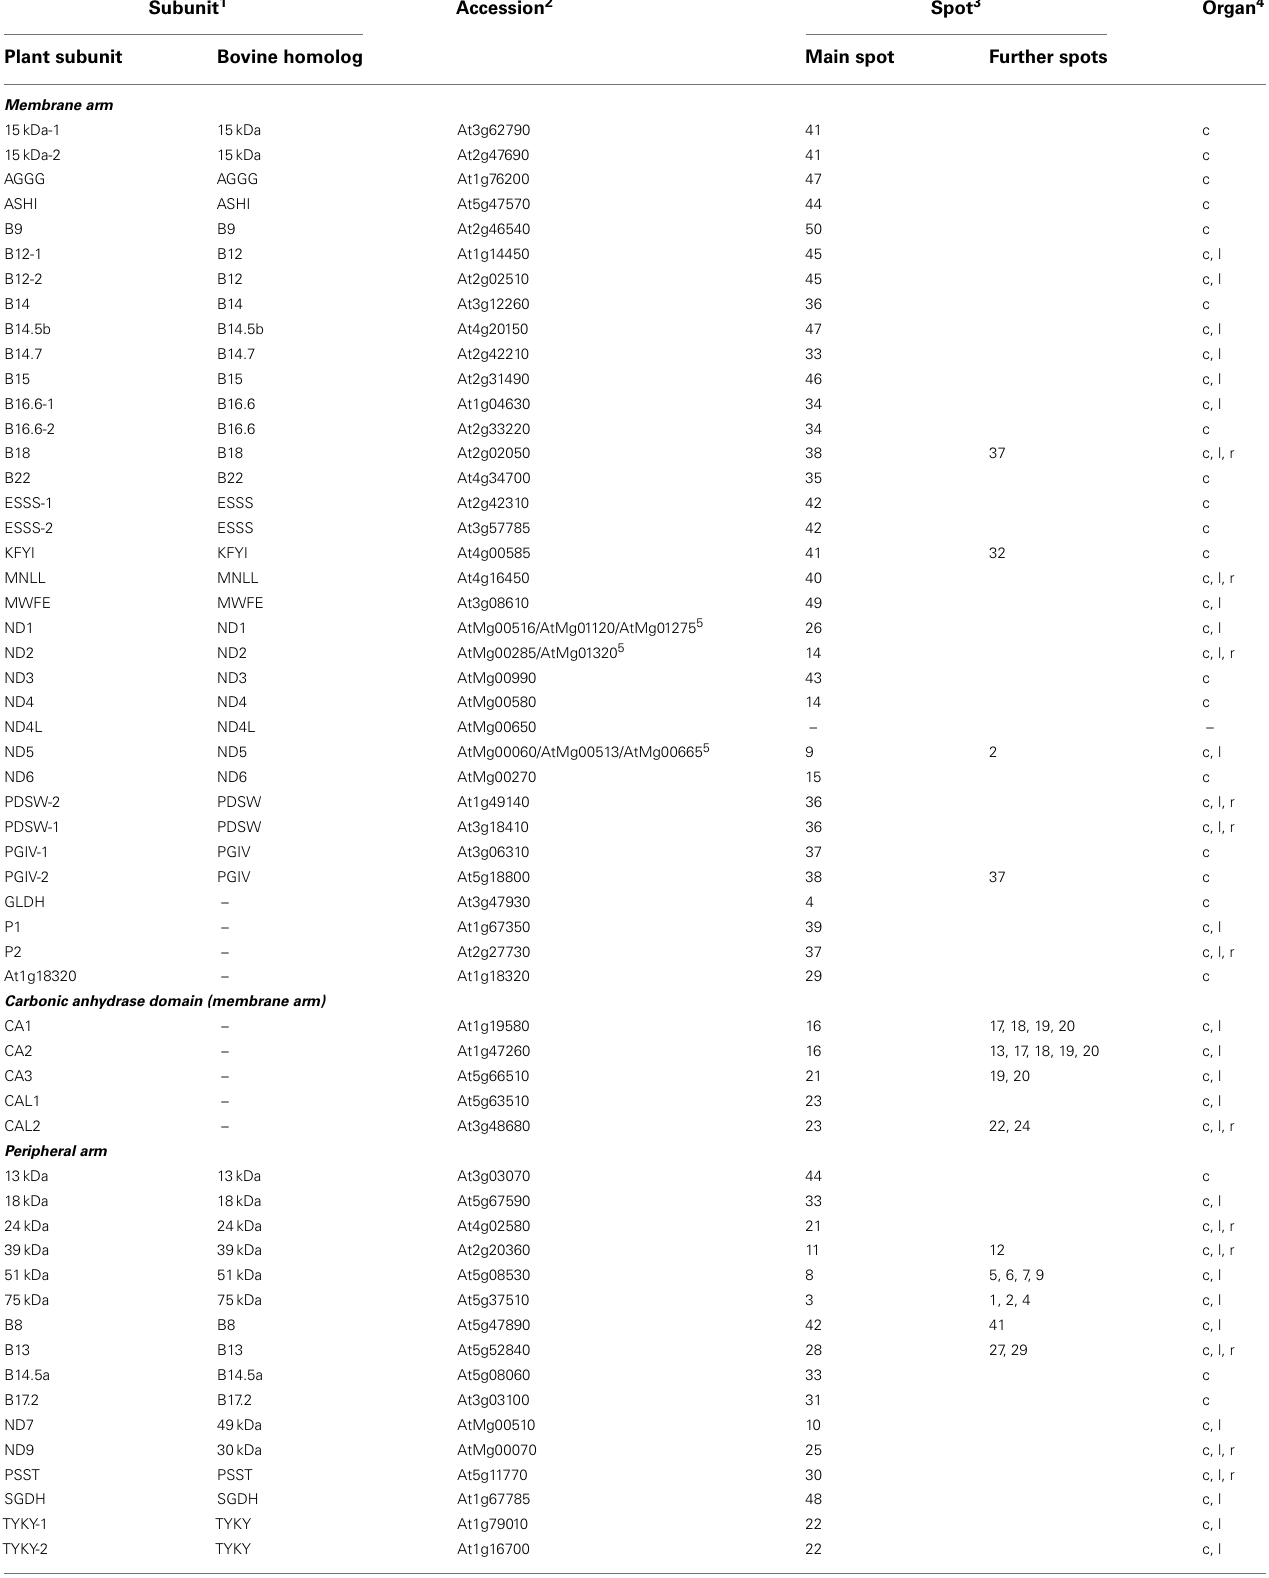
Table 1 | Complex I subunits in Arabidopsis thaliana . Subunit 1 Accession 2 Spot 3 Organ 4 Plant subunit Bovine homolog Main